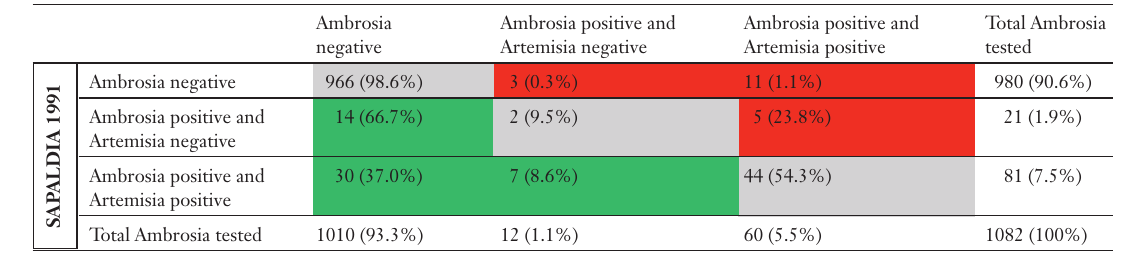
Red shaded: positive converters, i.e., subjects having become newly IgE positive (sensitised) between 1991 and 2002 Green shaded: negative converters, i.e., subjects having become IgE negative (lost sensitisation) between 1991 and 2002